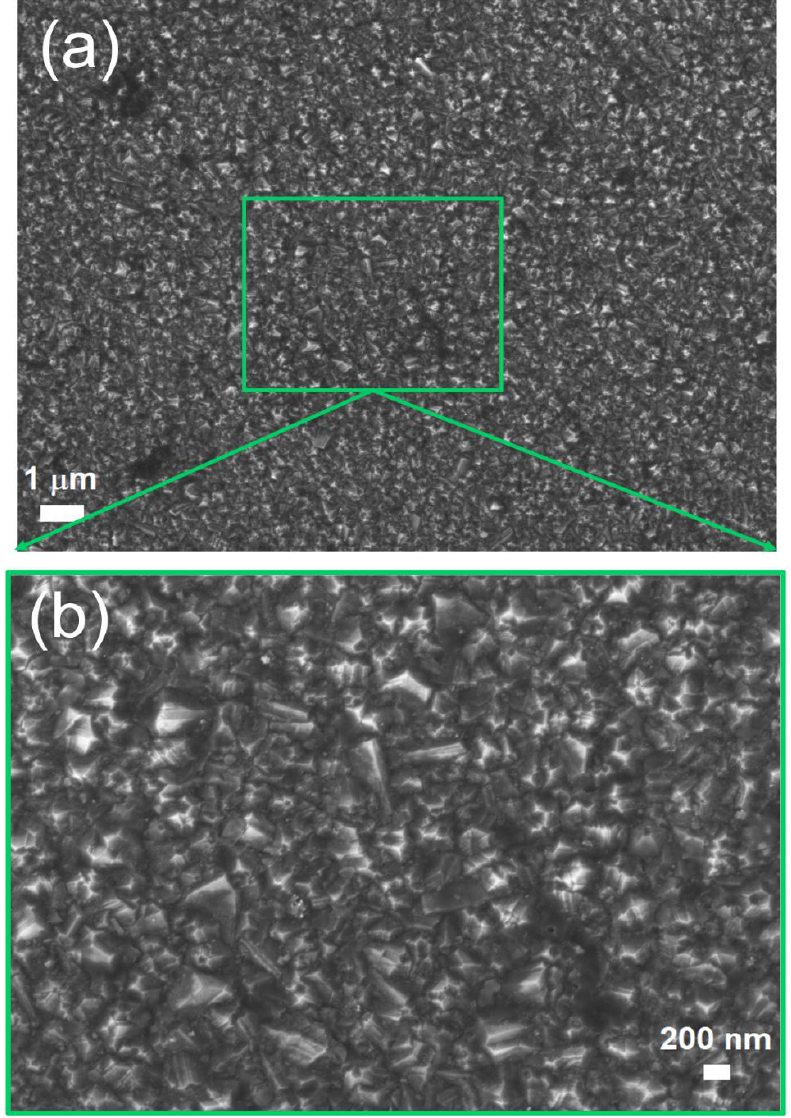
Figure 3. SEM micrograph recorded for BDD surface at different magnifications: ( a ) 17,000× and ( b ) 50,000×.